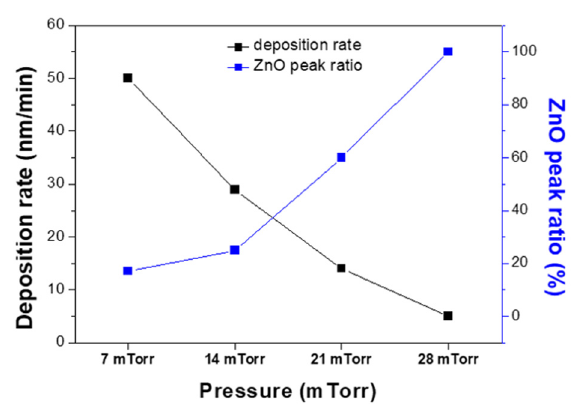
Figure 5. Deposition rates and ZnO peak ratios of the films upon variation in the process pressure.